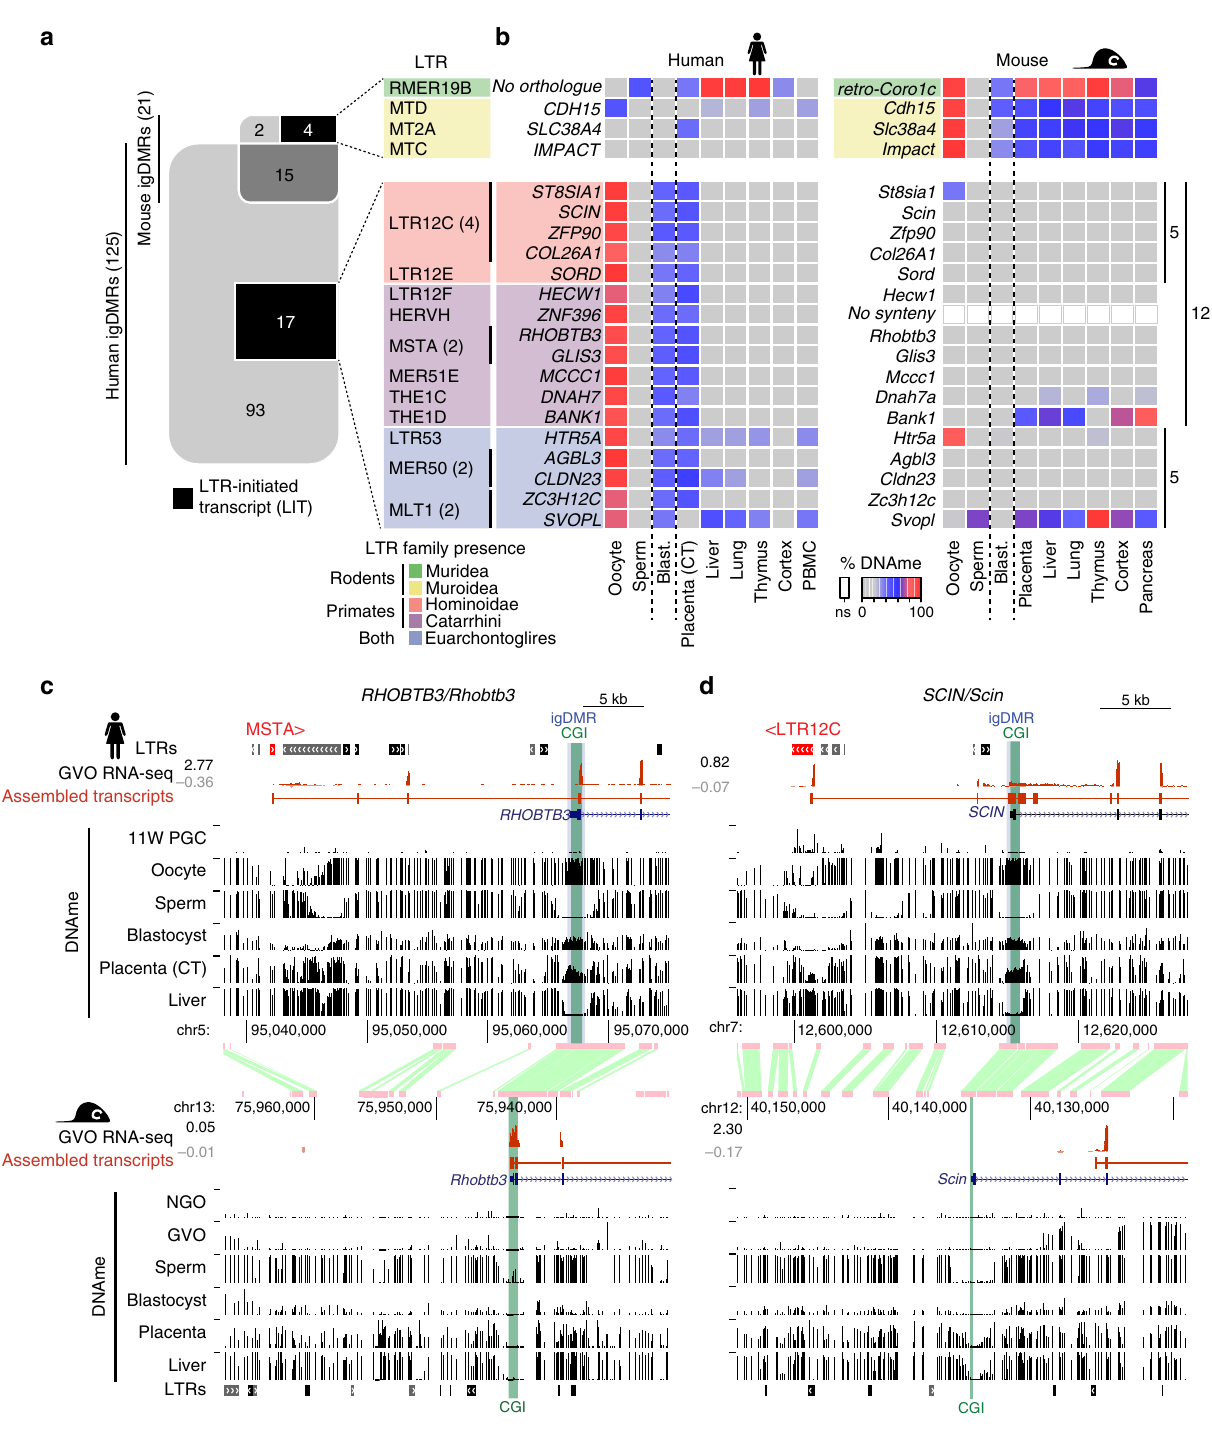
Fig. 1 Identi fi cation of human and mouse maternal igDMRs embedded within lineage-speci fi c LITs. a Venn diagram showing the intersection of known maternal igDMRs in mouse and human, along with the subset of igDMRs in each species embedded within a LIT. For each LIT-associated igDMR, the family of the LTR in which transcription initiates in oocytes is shown on the right. The presence of each LTR family in relevant mammalian lineages is color-coded as in Supplementary Fig. 1c. b List of imprinted genes/igDMRs associated with LITs. Maternal igDMRs unique to mouse (4) or human (17) are shown, along with DNAme levels (heat map) for each igDMR in syntenic regions in the gametes, blastocyst, placenta and adult tissues in human and mouse. The retrogene retro-Coro1c is absent in the syntenic human region on chromosome 6p22.3 ( No orthologue ). ZNF396 does not have a syntenic CGI in mice ( No synteny ). CT: cytotrophoblast; PBMC: peripheral blood mononuclear cell. c, d Screenshots of the human and mouse RHOBTB3/Rhobtb3 and SCIN/Scin loci, including locations of annotated genes, LTR retrotransposons, and regions of syntenic homology. The relevant CGI, igDMR, and upstream LTR in human are highlighted in green, blue, and red respectively. For each species, RNA-seq data from GVOs are shown, along with assembled transcripts, including LITs and their 5 ′ LTR exons (red) for the human genes. DNAme levels in gametes, blastocyst, placenta, and liver are shown across each locus in both species. For the human DNAme data, pro fi les from female 11-week primordial germs cells are also shown (11W PGC) and oocyte DNAme is from a mixture of GVO and MII oocytes. Details of all the datasets used in this study are presented in Supplementary Data